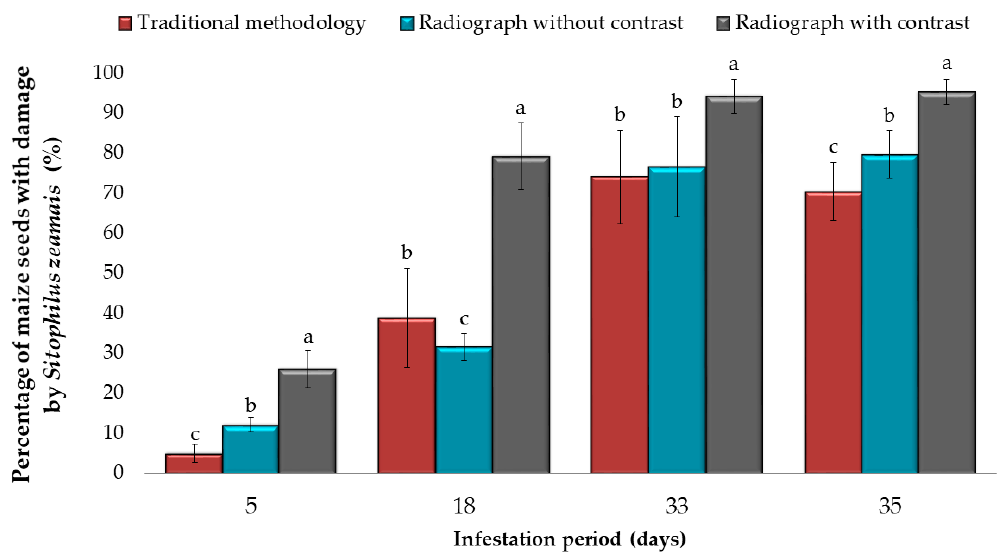
Figure 3. Average percentage of maize seeds with damage by Sitophilus zeamais in different assessment periods, assessed by traditional methods, radiograph without contrast and radiograph with contrast. The bar graph shows the means, and the error bars show the ± SD in each period of infestation (Tukey-Kramer Test, p < 0.05).